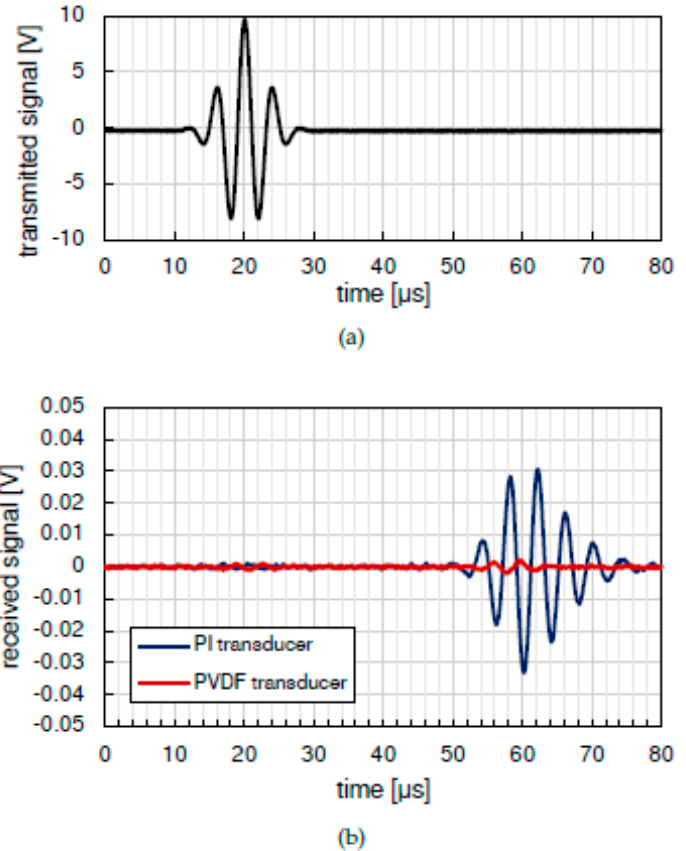
Figure 7. Experimental sensitivity comparison of the circular element with a commercial PZT sensor of same class: ( a ) transmitted Morlet with central frequency 250 kHz; ( b ) signals received from the two sensors (PI blue color and PVDF red color).